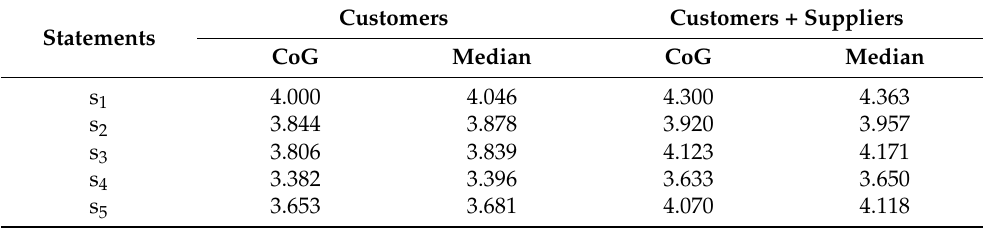
Table 6. Average ratings of the statements presented by the enterprise representatives after defuzzifi- cation the triangular fuzzy numbers (a group of customers vs. a group of customers and suppliers jointly).